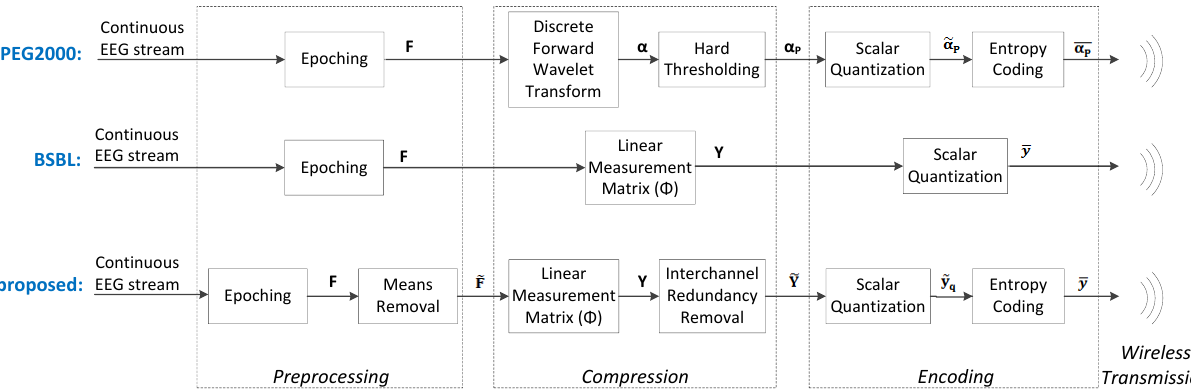
Figure 2. Block diagrams of the sensor node for (1) the JPEG2000-based framework ( Top ); (2) the Block-Sparse Bayesian Learning (BSBL) framework ( Middle ); and (3) the proposed compressed sensing (CS)-based framework ( Bottom ).